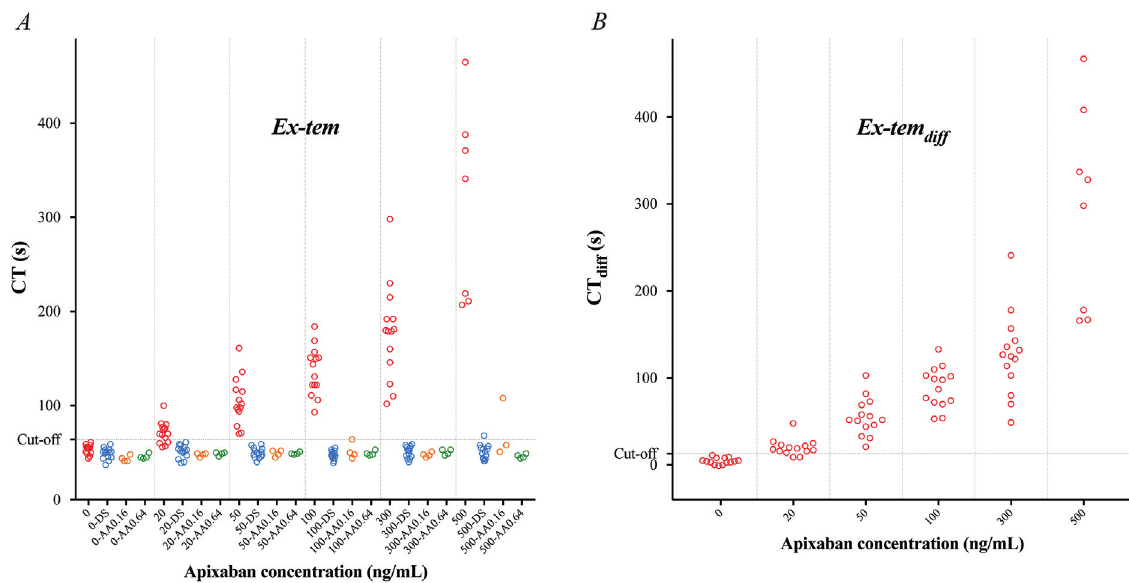
Fig. 1 Rotational thromboelastometry (ROTEM) analyses using the Ex-tem trigger – variables clotting time (CT) ( A ) and CT diff ( B ; the difference in CT without vs. with DOAC-Stop [DS]) – performed on blood samples from 14 healthy controls incubated with apixaban at estimated plasma concentrations 0, 20, 50, 100, 300, and 500ng/mL (red). Samples were analyzed in the absence or presence of DOAC-Stop (DS; blue) and andexanet alfa (AA; performed in samples from 4 out of 14 donors) – the latter in two different concentrations (0.16 [orange] and 0.64 [green] mg/mL). Cutoff line represents optimal receiver operating characteristics (ROCs) for discriminating between samples with apixaban concentration above or below